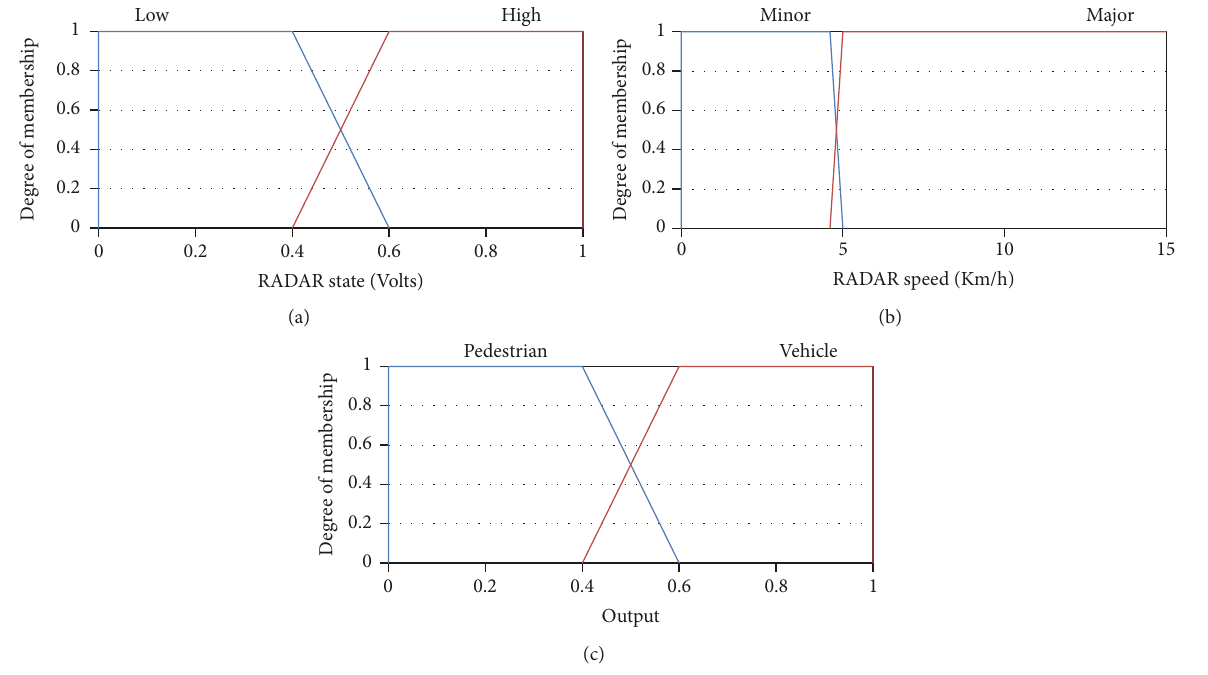
Figure 12: Labels for the RADAR fuzzy controller: (a) input for State, (b) input for Speed, and (c) output.